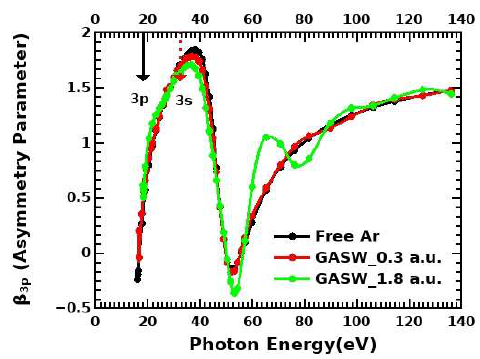
 Figure 3. The average angular asymmetric parameter β 3 p of free and Ar@C 60 . Vertical arrows indicate Figure 3. The average angular asymmetric parameter 3 p of free and Ar@C 60 . Vertical arrows in- the threshold values of the corresponding subshells used in the RRPA. dicate the threshold values of the corresponding subshells used in the RRPA.